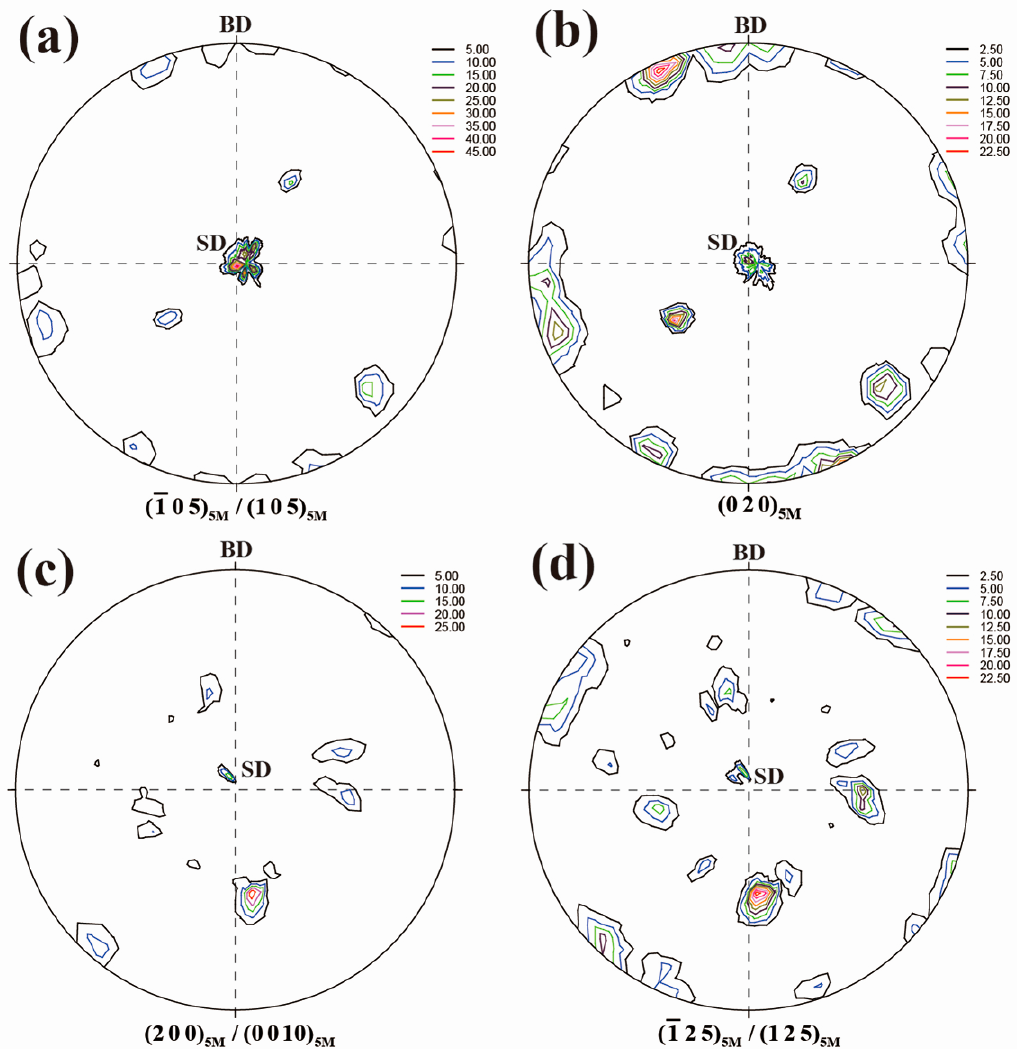
Figure 5. Complete pole figures of directionally solidified Ni 50 Mn 28.5 Ga 21.5 alloy without thermo-mechanical treatment measured from neutron diffraction (BD: incoming beam direction; SD: solidification direction) [38]: ( a ) {1 0 5} 5M /{ − 1 0 5} 5M pole figure; ( b ) {0 2 0} 5M pole figure; ( c ) {0 0 10} 5M /{2 0 0} 5M pole figure; and ( d ) {1 2 5} 5M /{ − 1 2 5} 5M pole figure.